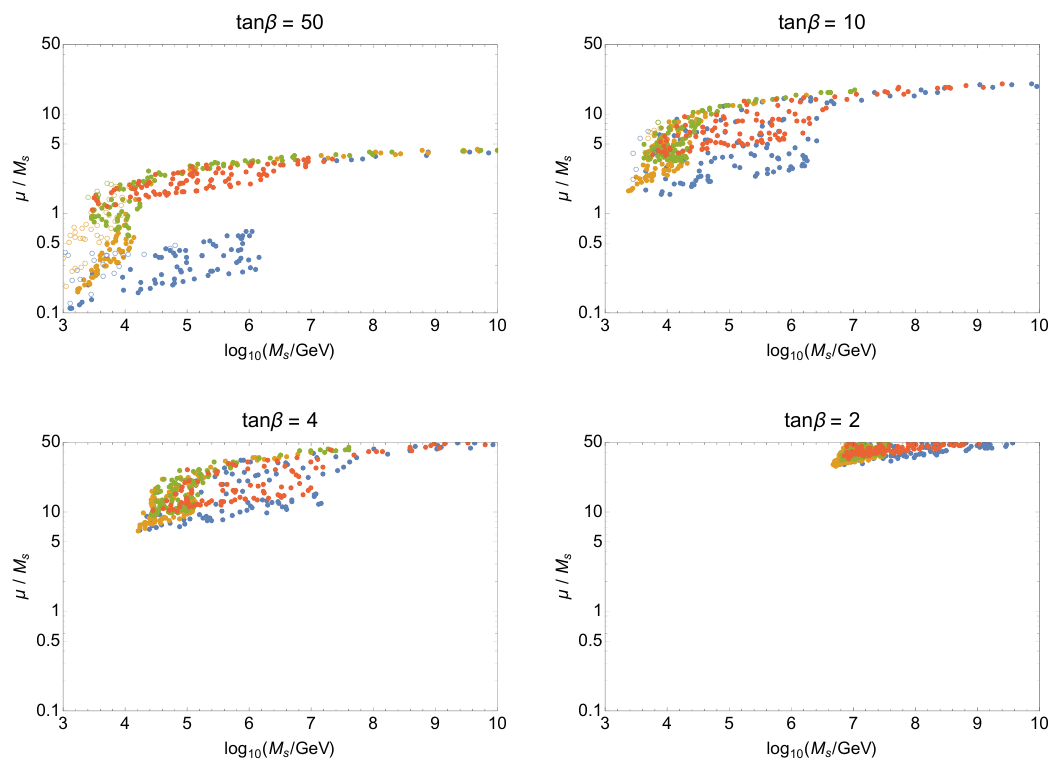
Figure 1 . Points in the MSSM parameter space that allow consistent matching onto the SMEFT and meanwhile realize b - (cid:28) Yukawa uni(cid:12)cation, projected onto (log M s ; (cid:22)=M s ) plane, for several choices of tan (cid:12) . Blue, yellow, green, red points have x t (cid:17) ( A t (cid:0) (cid:22) cot (cid:12) ) =M s 2 (cid:0)p (cid:0)p p p ( (cid:0) 4 ; 6) ; ( 6 ; 0) ; (0 ; 6) ; ( 6 ; 4), respectively. Empty circles represent solutions with a gluino lighter than 2 TeV, potentially already in tension with direct LHC searches, depending on decay